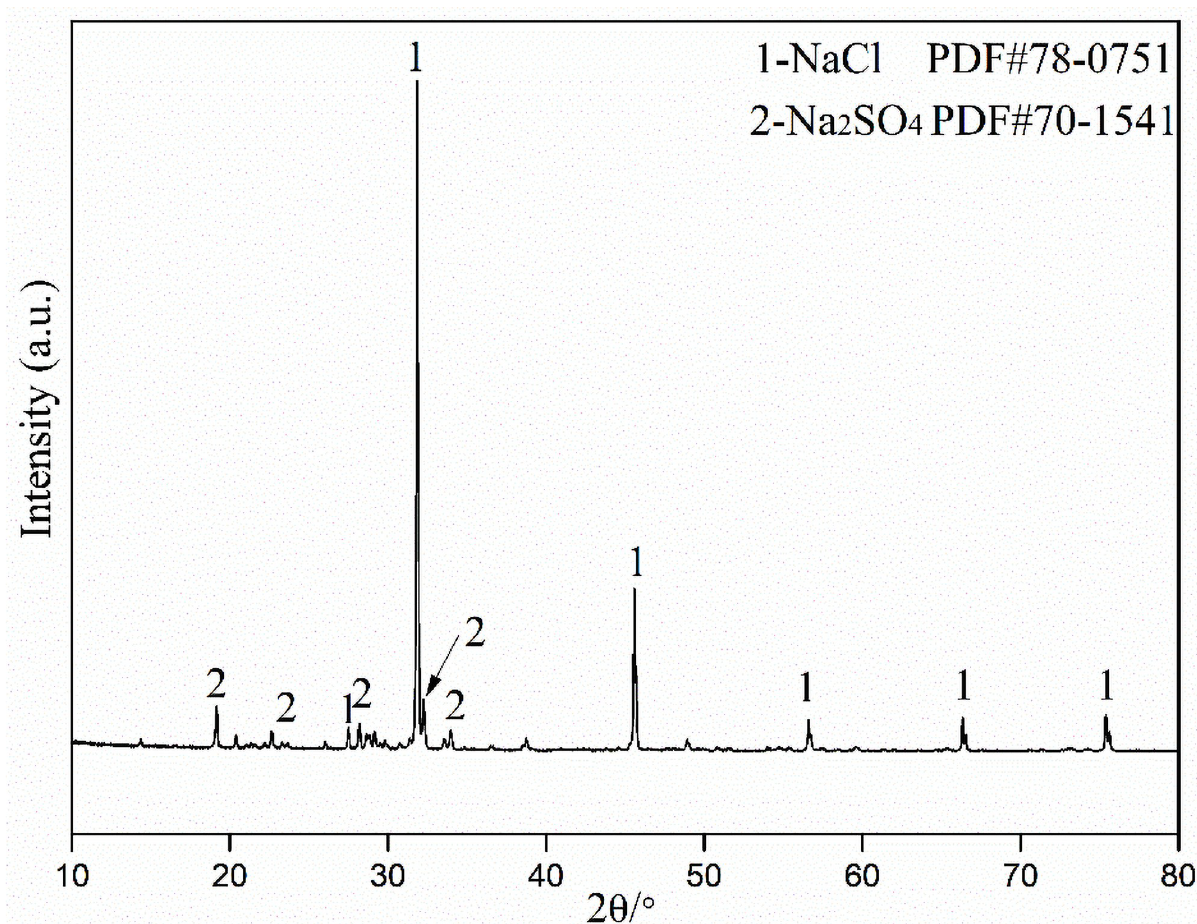
Fig 2. XRD pattern of the industrial waste